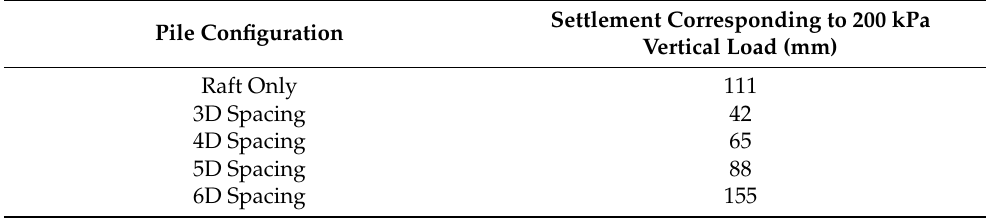
Table 6. Pile spacing and